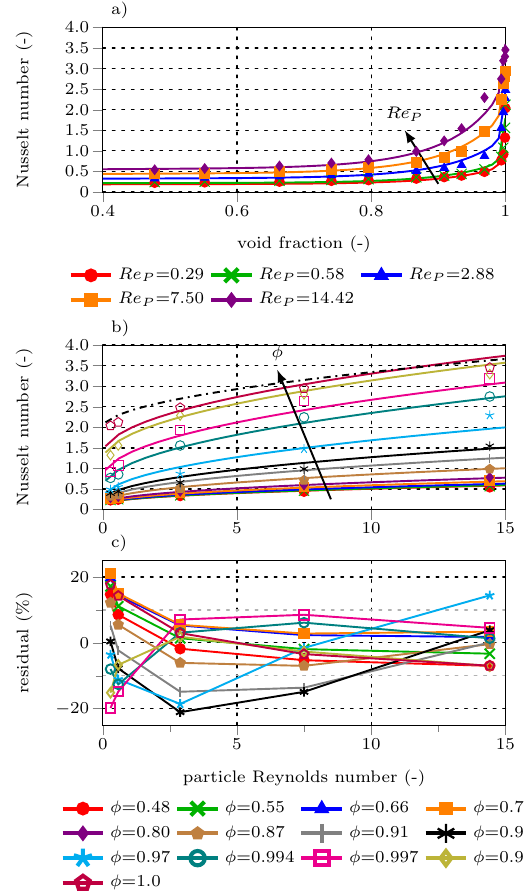
Figure 10. Comparison of Nusselt number correlation ( ) Equation (16) with simulation data ( ) versus the cluster void fraction ( a ) and particle Reynolds number ( b ). The relative errors of Equation (16) compared to CFD-simulated data are presented in ( c